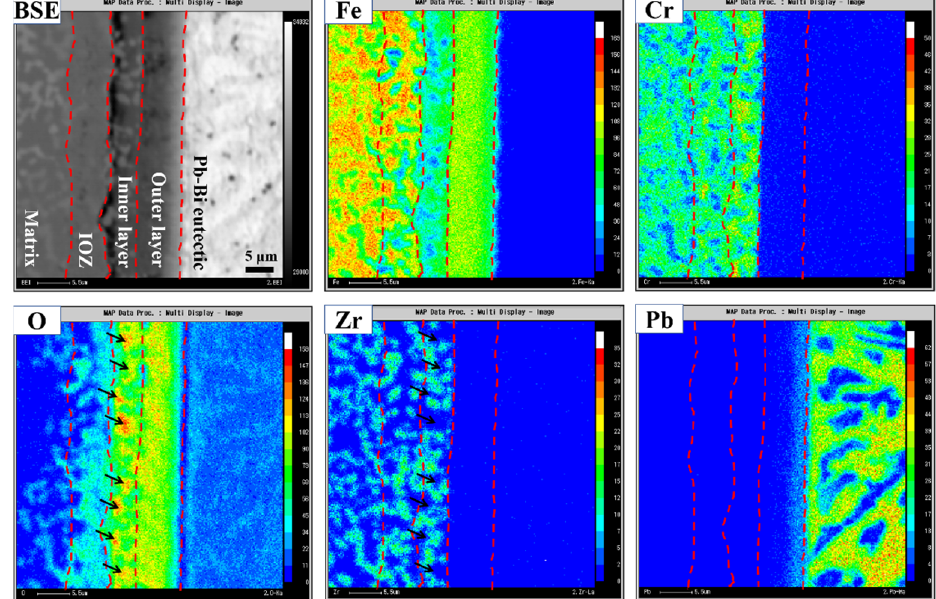
Figure 9. EPMA analysis of the cross-sectional area of Fe-Cr-Zr alloy after exposure to oxygen-saturated Pb-Bi eutectic at 823 K for 1000 h.